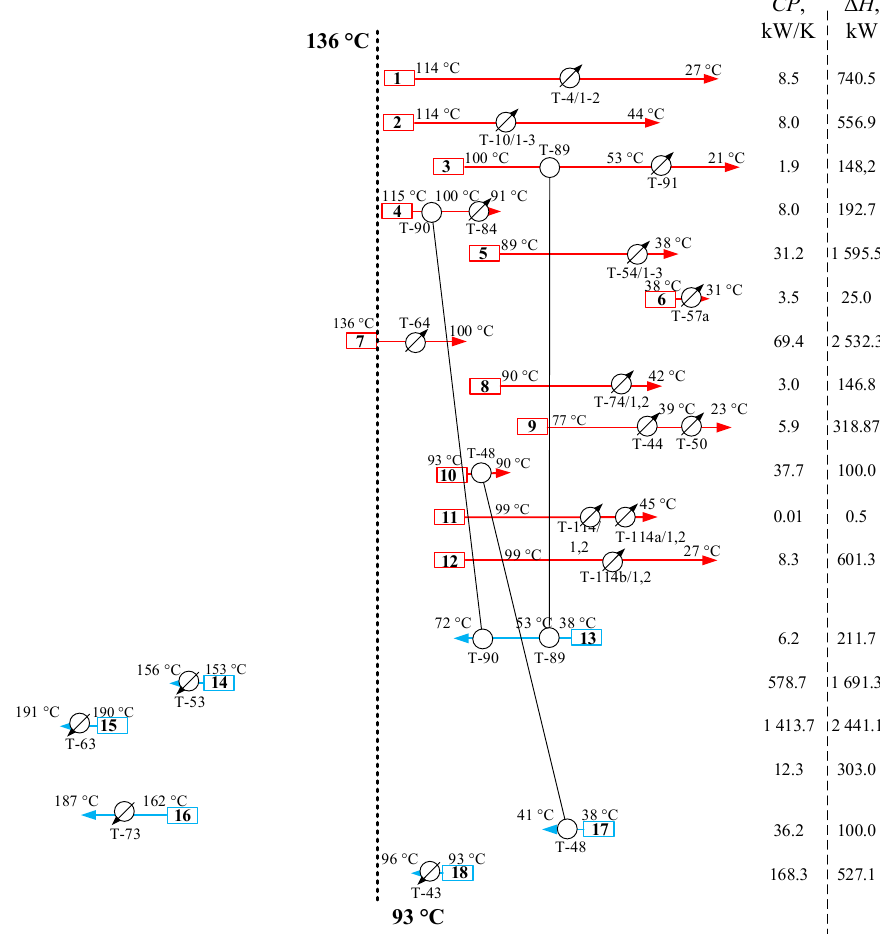
Figure 4. Grid diagram existing HEN of the EB production process.